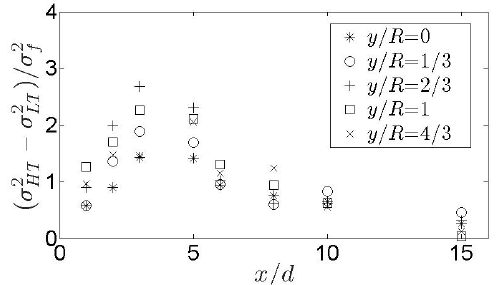
− σ 2 ) / σ 2 , HT LT f